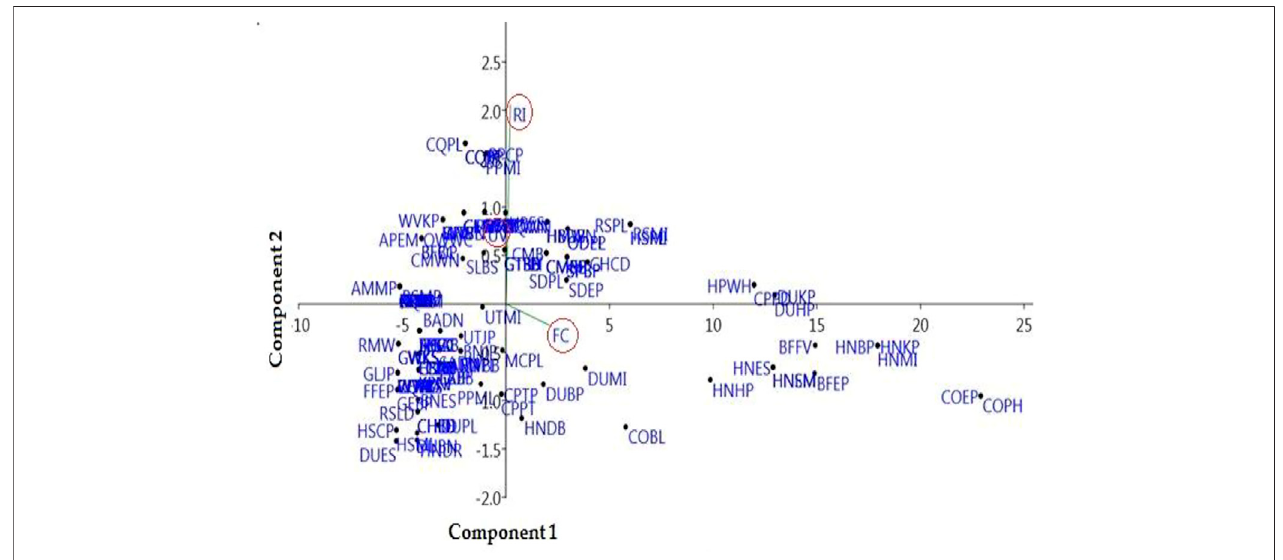
FIGURE10 | Clusteranalysisshowing thesimilaritiesamong species (codes arepresentin Supplementary Table S1 ) in different variables (UV, FC, and RI) ofthe district Haveli.